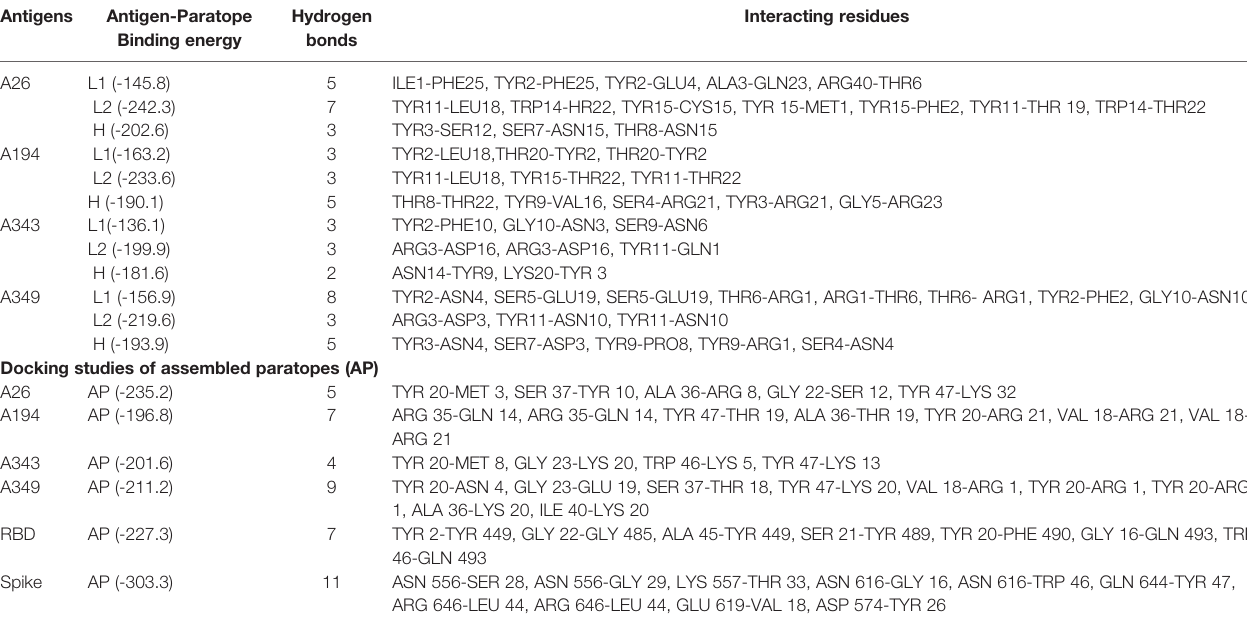
TABLE 4 | Antigen and paratope docking studies. Antigens Antigen-Paratope Hydrogen Binding energy